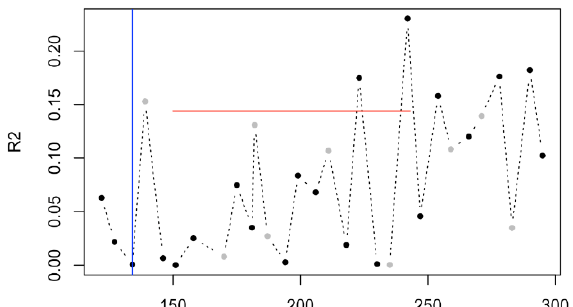
Figure 6. R 2 of the multi-temporal Sentinel-1 VH polarization over time. The axis is the day of year in 2017, and the blue line represents the data used in Section 1; the red line represents the R 2 using the mean value between day 150 and 250 when the leaves are still on the trees. Black points are from models based on all 237 plots. Gray points are from models based on less than all 237 plots and thus may not be as reliable.